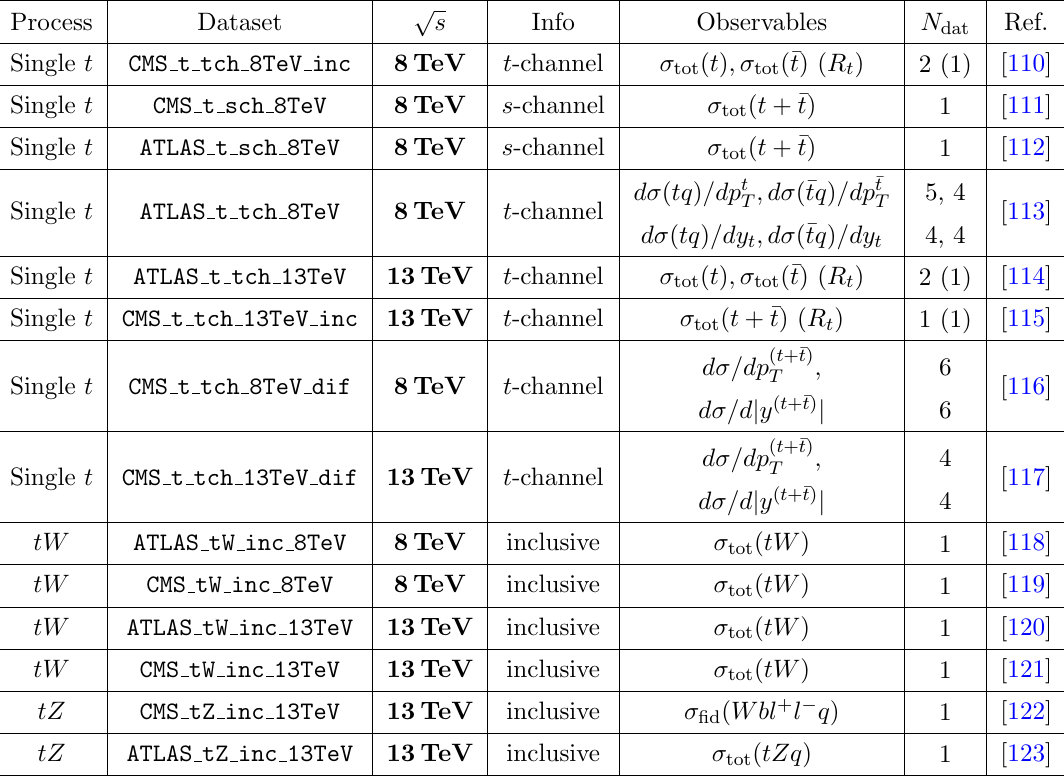
Table 4 . Same as table 2, now for inclusive single t production and single t production in association with vector